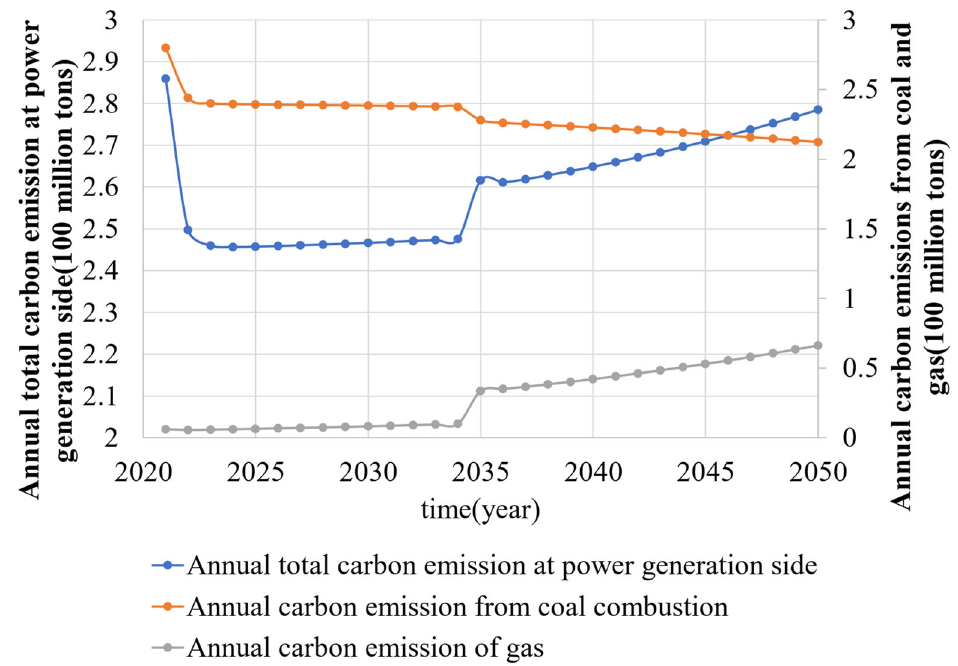
Figure 4. Different types of carbon emissions at the generation side under basic scenarios.